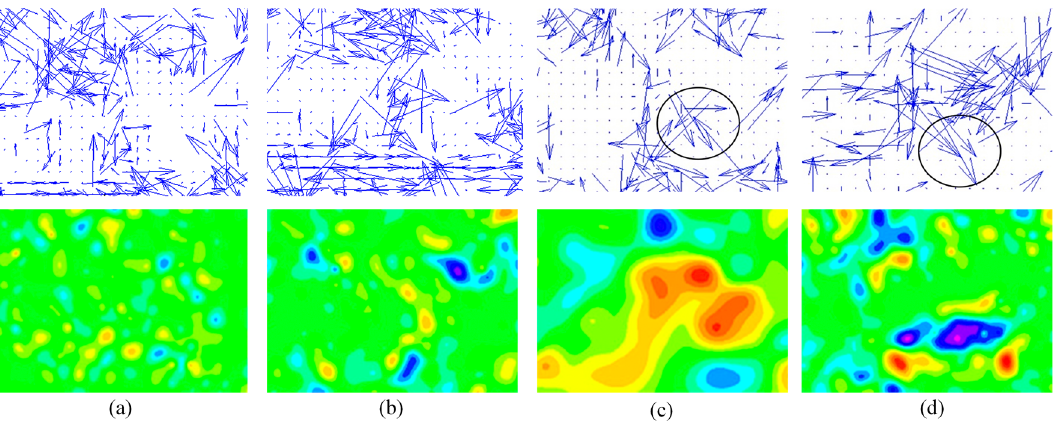
Figure 20. Vector-vorticity diagrams of the bubble bursting on the wall: ( a ) t = 1 µ s, ( b ) t = 32 µ s, ( c ) t = 55 µ s, ( d ) t = 60 µ s.